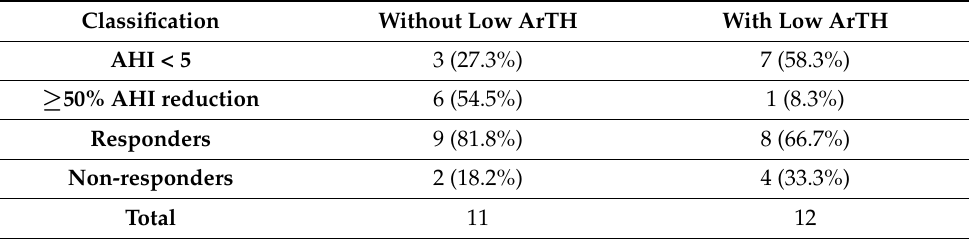
Table 5. Patients’ responders (for one of the three definitions: AHI < 5/h, AHI < 10/h plus > 50% reduction from baseline, or ≥ 50% reduction from baseline) or non-responders with or without low